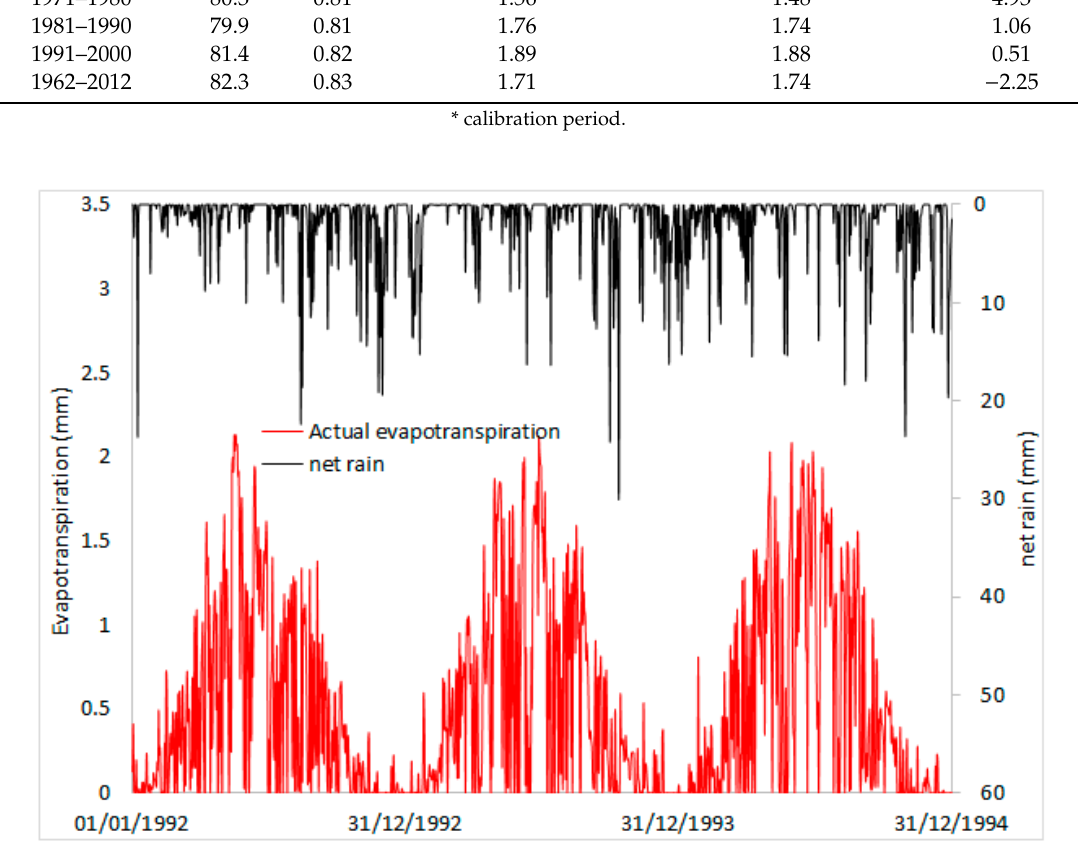
Figure 6. The actual evapotranspiration and net-rainfall for the Frome catchment during the drought period 1992–1994. Table 2. Model performance during the calibration and validation stages of the Frome streamflow. Time Period